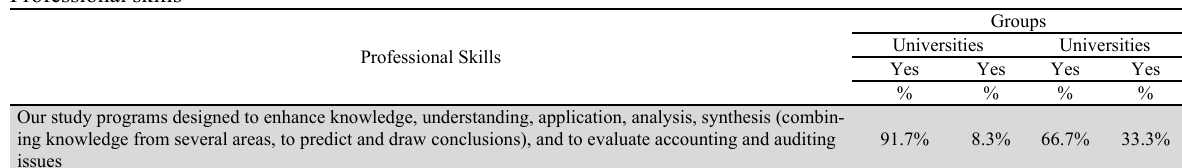
Professional Skills